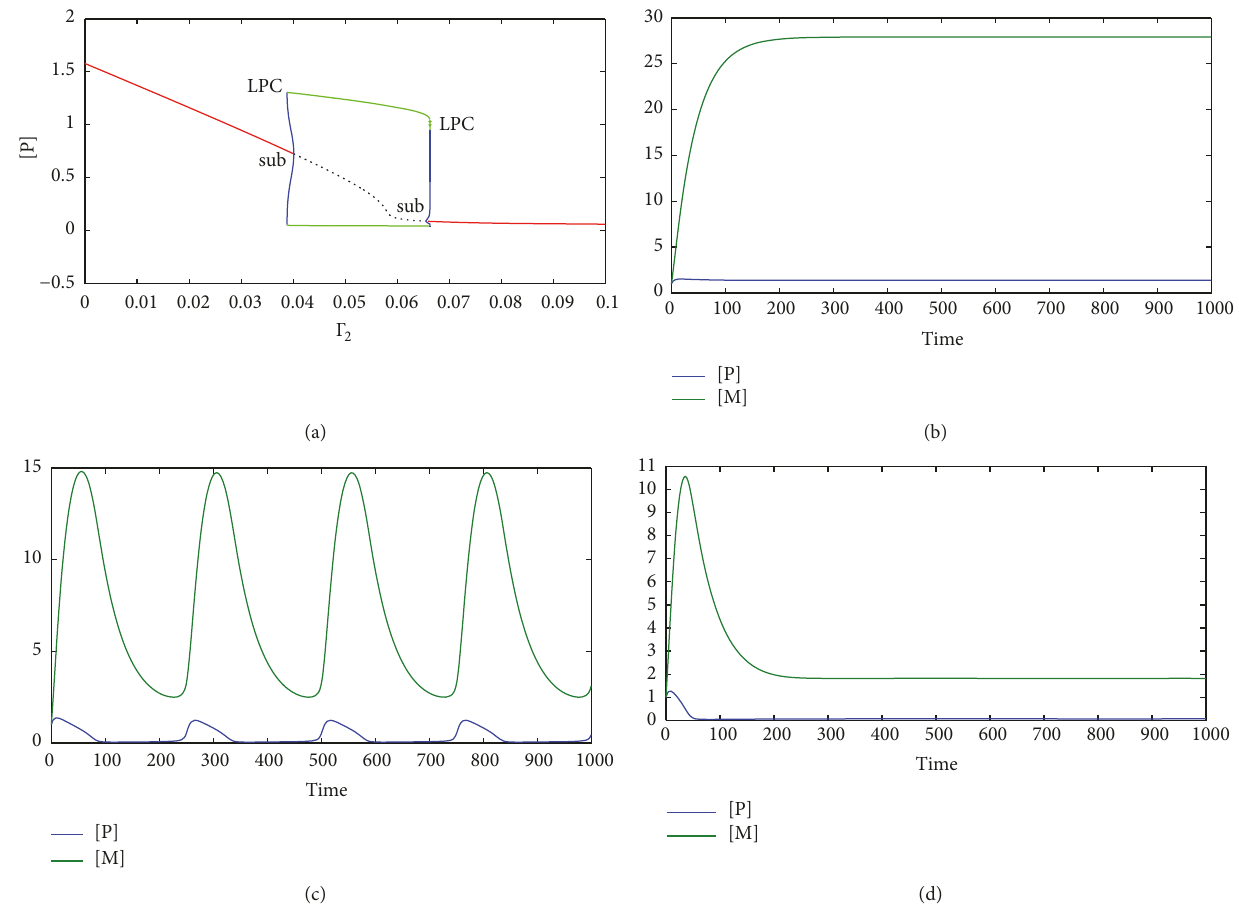
Figure 2: (a) Bifurcation diagram of [P] with Γ 2 as a bifurcation parameter. The red solid lines depict stable steady states and the black dashed line depicts unstable steady states. The maxima and minima are depicted by the blue dots and green dots for the stable and unstable limit cycle, respectively. The bifurcation points of the subcritical Hopf bifurcation are marked as sub and LPC as fold limit cycle bifurcation points. (b), (c), and (d) are time courses diagram of 𝑃 and 𝑀 for the parameter Γ 2 =0.01(b), 0.05(c), and 0.09 (d), respectively. The initial conditions: 𝑃(0) = 0.1, 𝑀(0) = 0.1